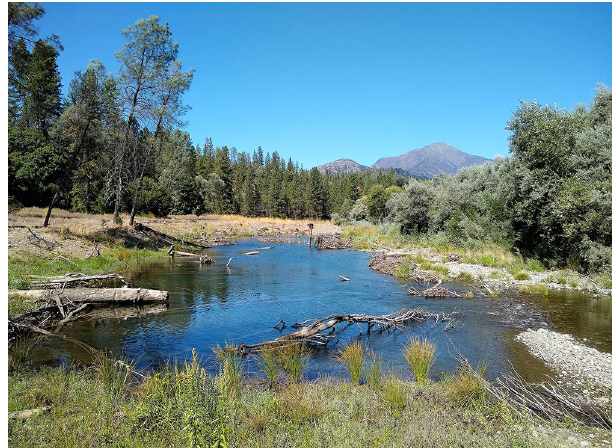
Figure 1. Side channel with wood placements at the Trinity River, California, USA (photo: I.